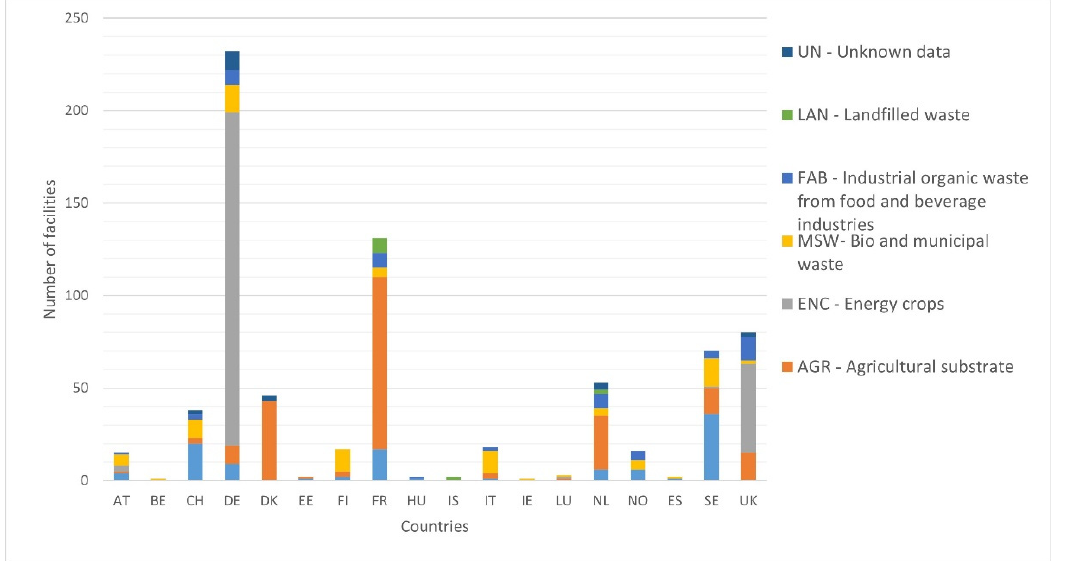
Figure 8. Distribution of facilities per feedstock in EU member states, UK and Norway (according to [136]).